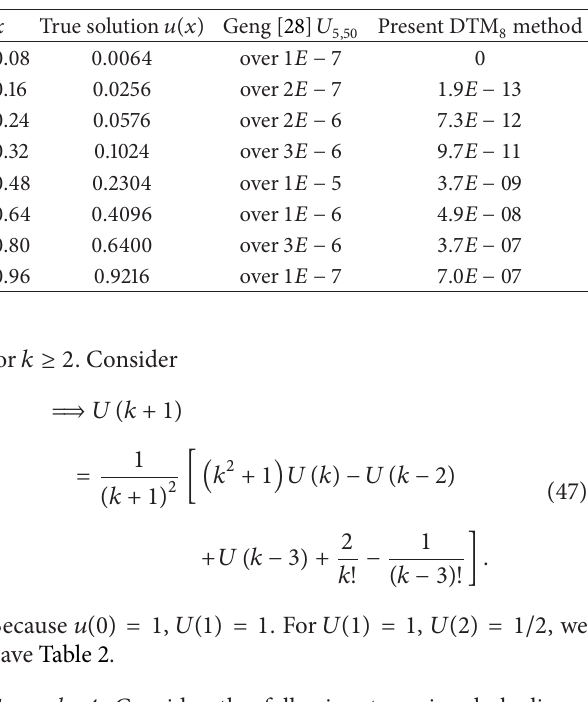
Table 3: Comparison of relative errors of the present method for Example